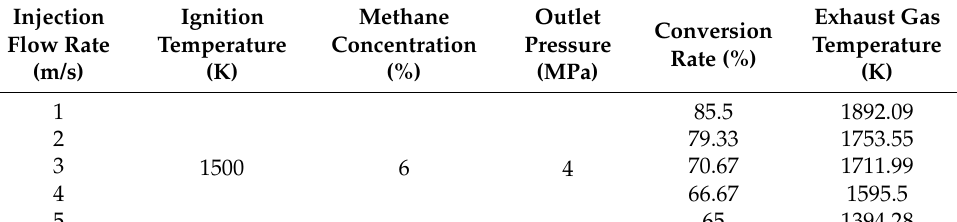
Table 6. Simulation parameters of the influence of injection rate on conversion rate and exhaust gas temperature at 4 MPa.